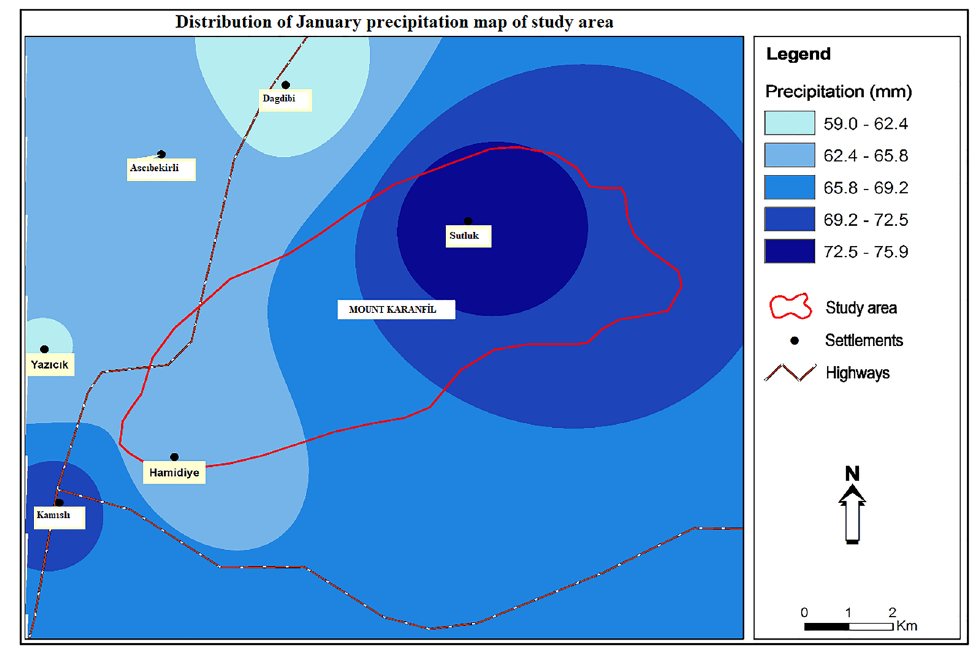
Fig. 16 Distribution of January precipitation map of study